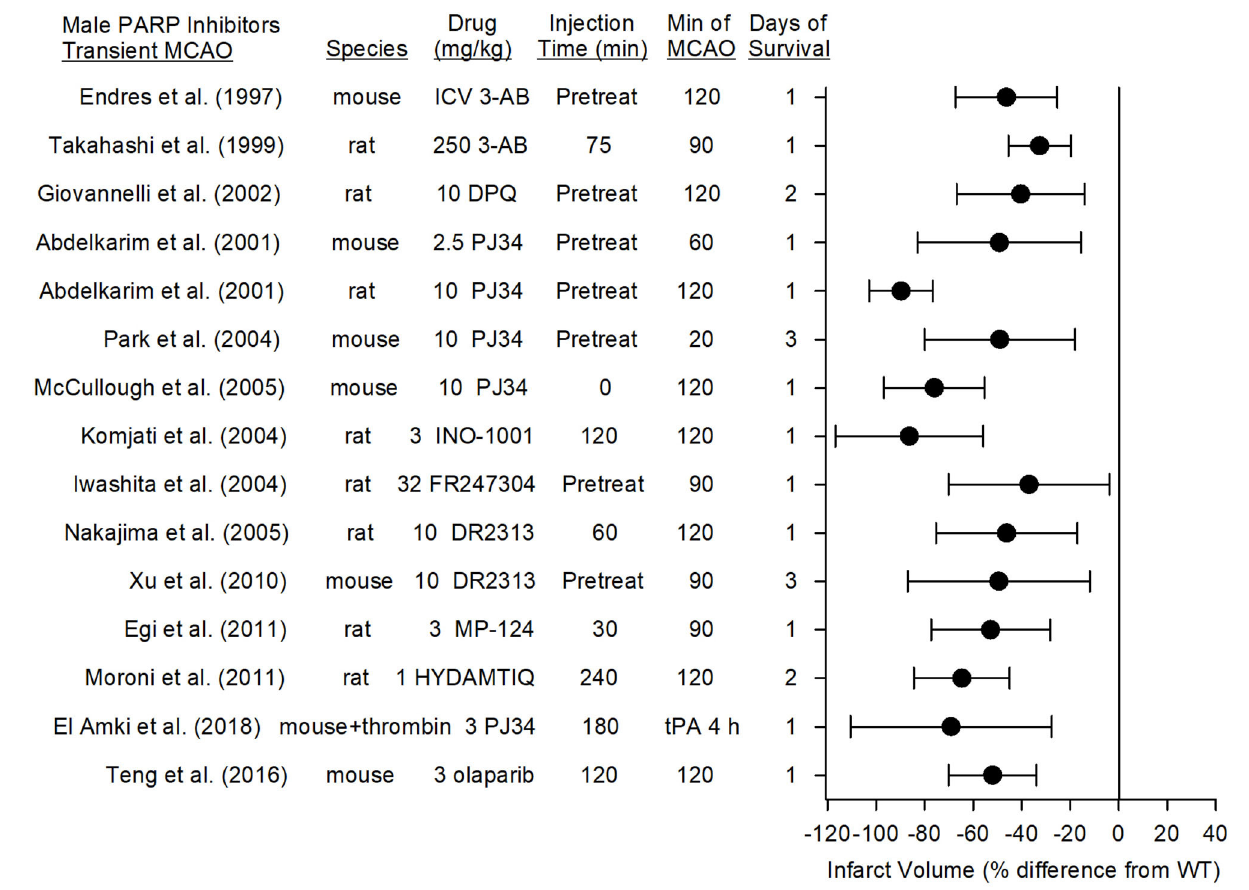
FIGURE 4 | Effect sizes and 95% confidence intervals of PARP inhibitor treatment on infarct volume after transient middle cerebral artery occlusion (MCAO) in male mice and male rats, relative to their respective controls, were derived from mean and SD values and sample sizes extracted from publications by Endres et al. (68), Takahashi and Greenberg ( 83), Giovannelli et al. (76), Abdelkarim et al. (84), Park et al. (62), McCullough et al. (70), Komjati et al. (85), Iwashita et al. (86), Nakajima et al. (87), Xu et al. (81), Egi et al. (88), Moroni et al. (89), El Amki et al. (90), and Teng et al. (91). These reports from 12 different laboratories using 9 distinct inhibitors showed a significant reduction in infarct